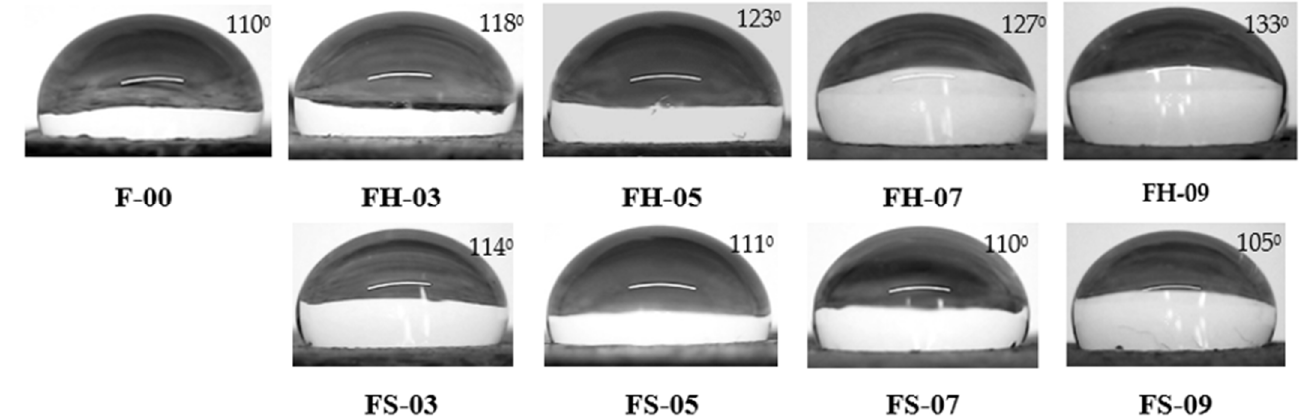
Figure 8. The contact angle of water on the NFR at various compositions.